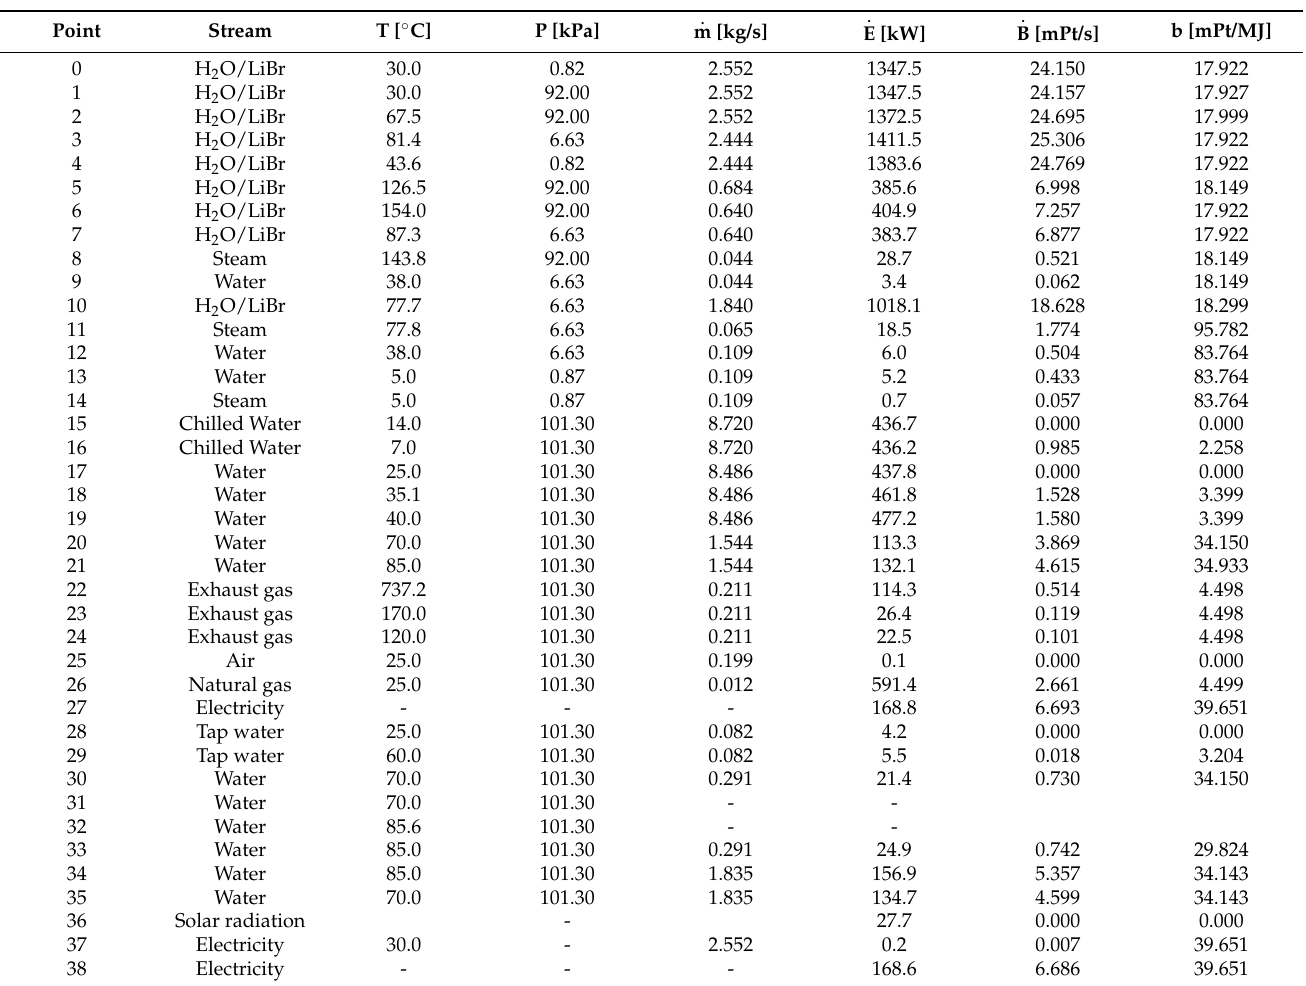
Table 3. Exergoenvironmental parameters of the trigeneration